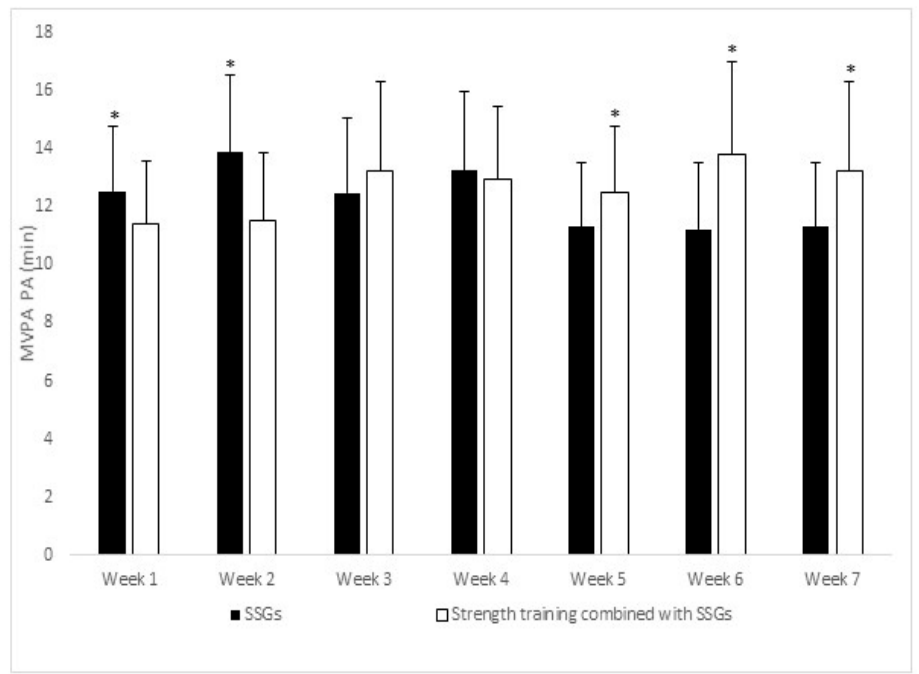
Figure 1. Moderate to vigorous physical activity (MVPA) by weeks. * denotes p < 0.05 differences. SSGs, small-sided games. Int. J. Environ. Res. Public Health 2021 , 18 , x